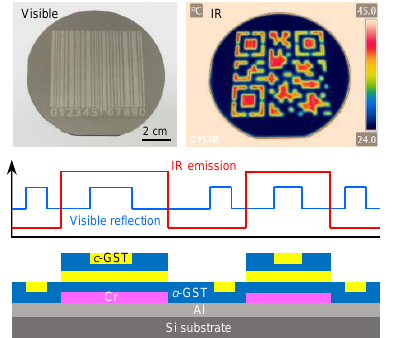
Fig. 1. Structure of a GST cavity fabricated on a Si substrate along with its visible and IR images. a -GST represents amorphous GST and c -GST refers to crystalline GST.